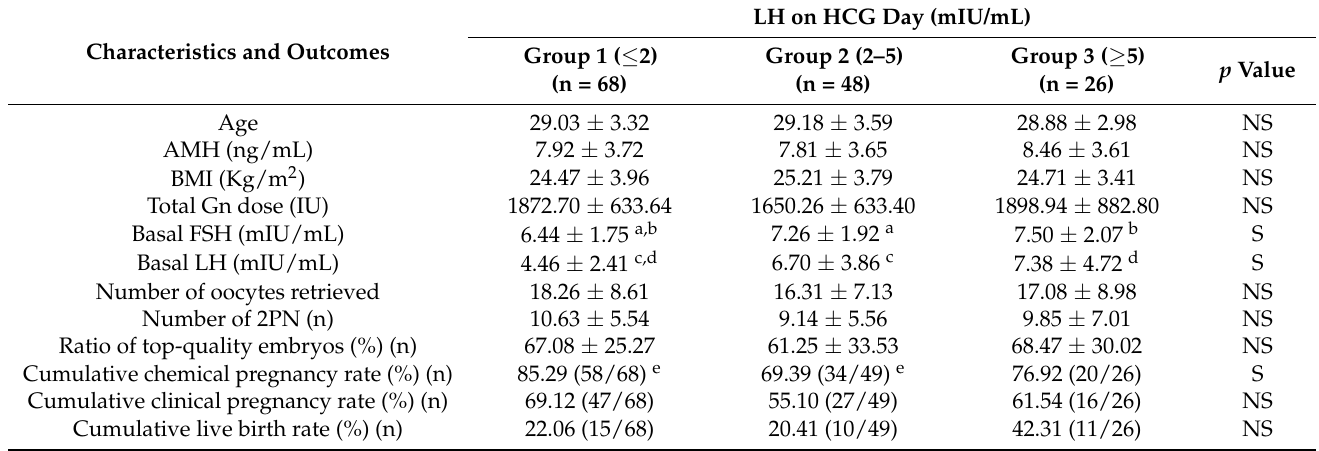
Table 3. Characteristics and outcomes of grouped by LH on HCG day.